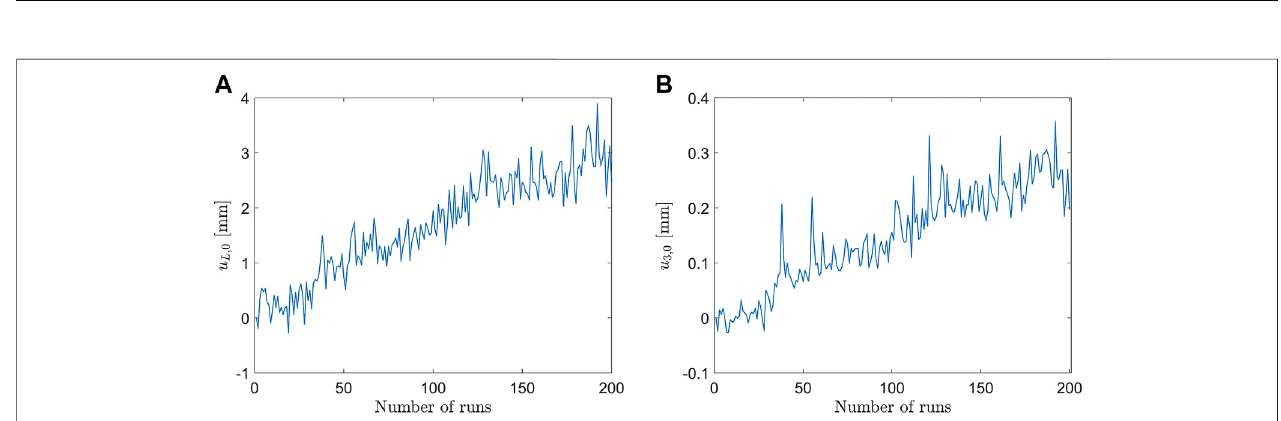
FIGURE5| Timehistoryresponseofthehybridmodelwith K 1 (cid:1) 224.454 Nm/rad, K 2 (cid:1) 118.235 Nm/rad, F max (cid:1) 48 Nm, T (cid:1) 0.618 sand θ max (cid:1) 116.73 ° C: (A) out- of-plane displacement and (B) axial displacement.